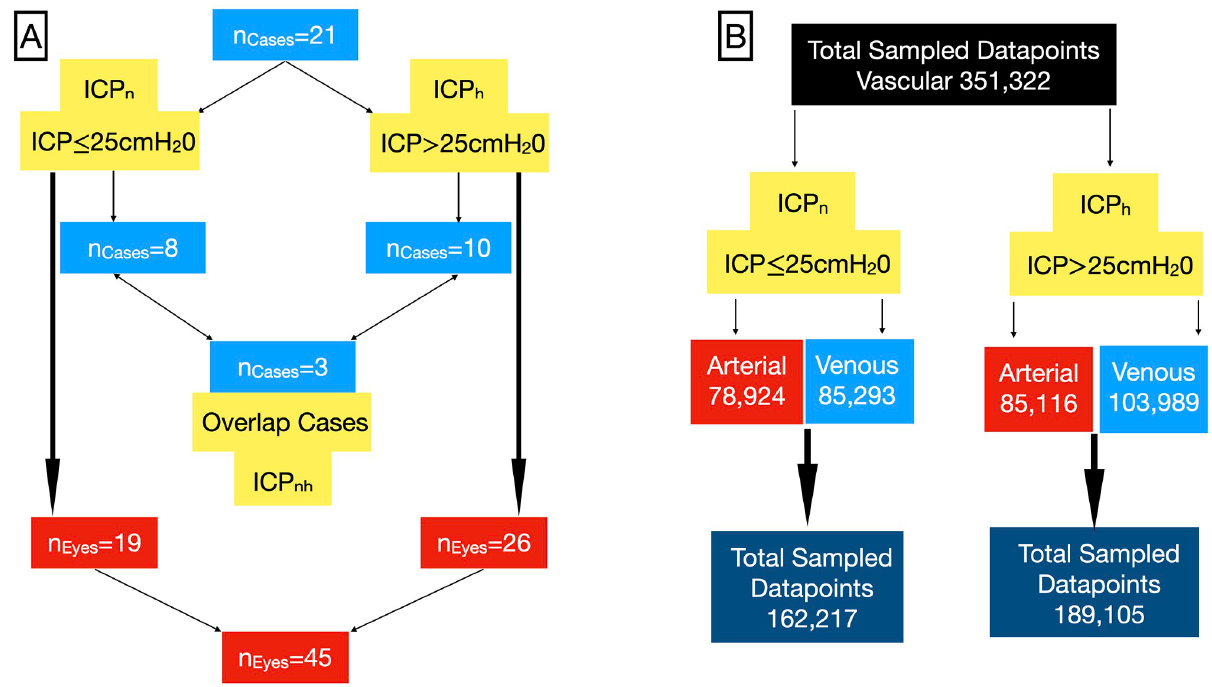
Fig 1. Classification of the study population and image data points. A) A total of 21 subjects were classified into two groups dependent on the intracranial pressure (ICP). An ICP of 25 cm water was the normal upper limit. B) A total of 351,322 data points were sampled from the images.